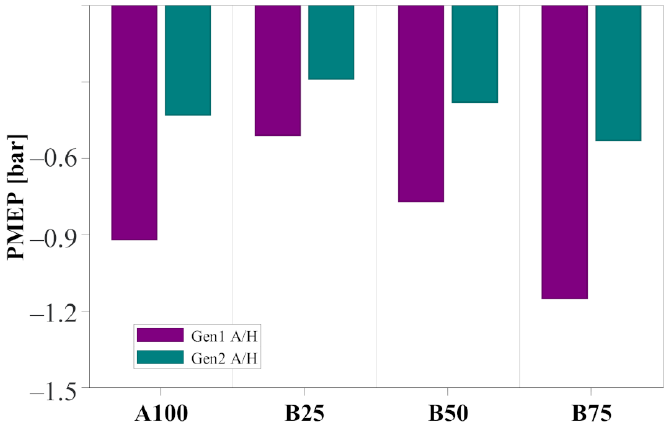
Figure 19. Comparison of PMEP between Gen1 A/H and Gen2